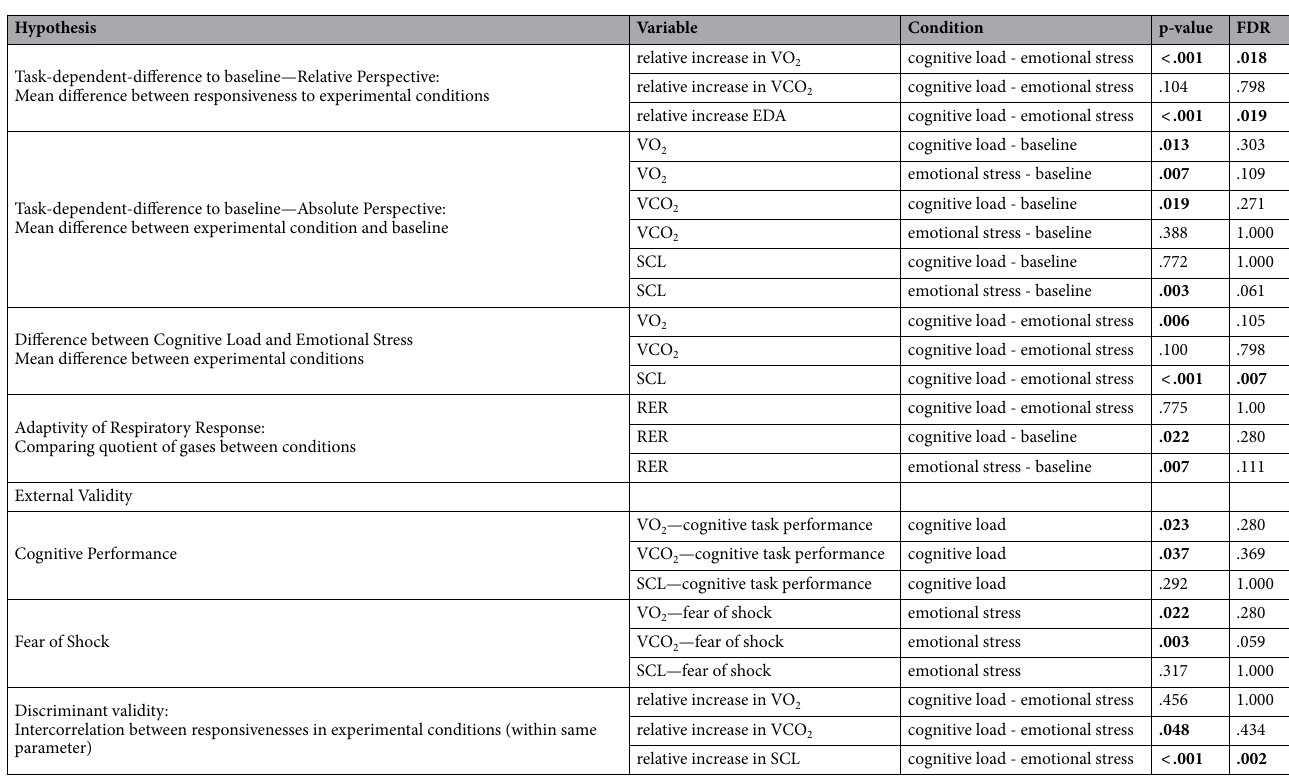
Table 2. Inference statistical results sorted by hypotheses and relevant physiological variables/conditions. Experimental conditions refer to emotional stress induction and cognitive load and are to be differentiated from baseline condition. We defined responsiveness of a physiological parameter to an experimental condition as the difference between its mean values in baseline and the corresponding experimental condition, expressed in percent of its baseline value. False discovery rate (FDR) is given for each tested hypothesis. Sample size for all tests was N = 27 except for EDA ( N = 25). SCL: mean skin conductance level (µS), VO2: Volume of oxygen uptake (l/min), VCO2: Volume of carbon dioxide output (l/min), RER: Respiratory Exchange Ratio (VCO2/